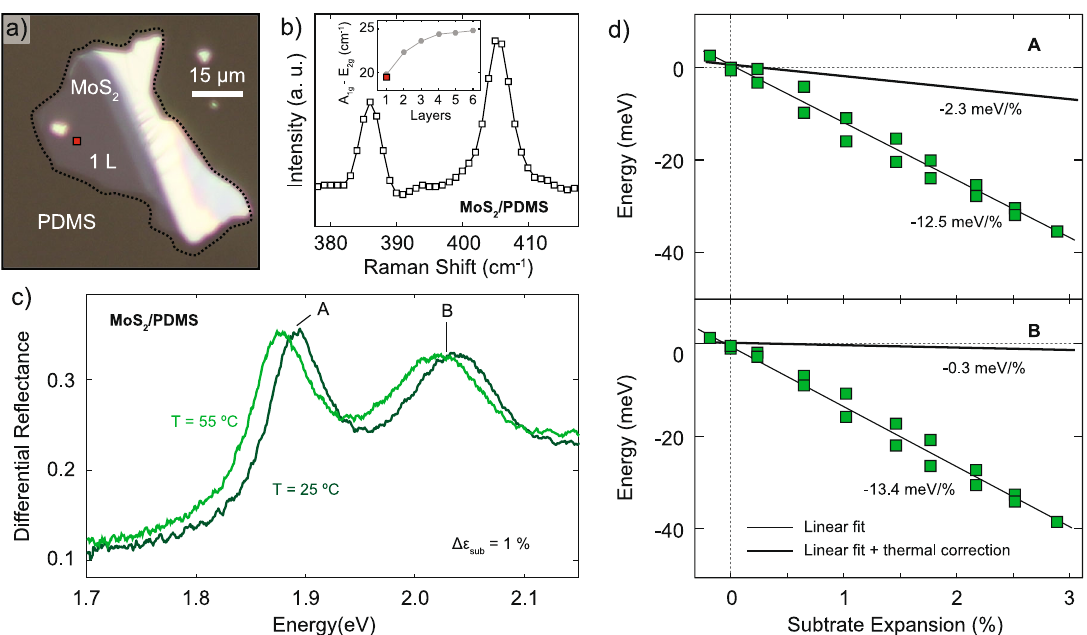
Fig. 2 a Optical image of a MoS 2 fl ake deposited on a PDMS substrate; the darker violet region is single-layer MoS 2 . The contour of the fl ake is outlined by a black dashed line . b Raman spectrum of the MoS 2 fl ake taken at the position of the red square in panel ( a ). The inset shows the dependence of the difference in Raman shift of the modes A 1g and E 2g as a function of the number of layers, the red square indicates the value found in this study. c Differential re fl ectance measured on the single-layer region of the MoS 2 fl ake for zero substrate expansion ( light coloured curve ) and at 1 % of substrate expansion ( dark curve ). d Energy of the excitonic peaks A, B in panel ( c ), extracted from a multi-peak fi t as a function of the substrate expansion. The thin lines represent a linear fi t to the data, while the thick line represents the same trend after